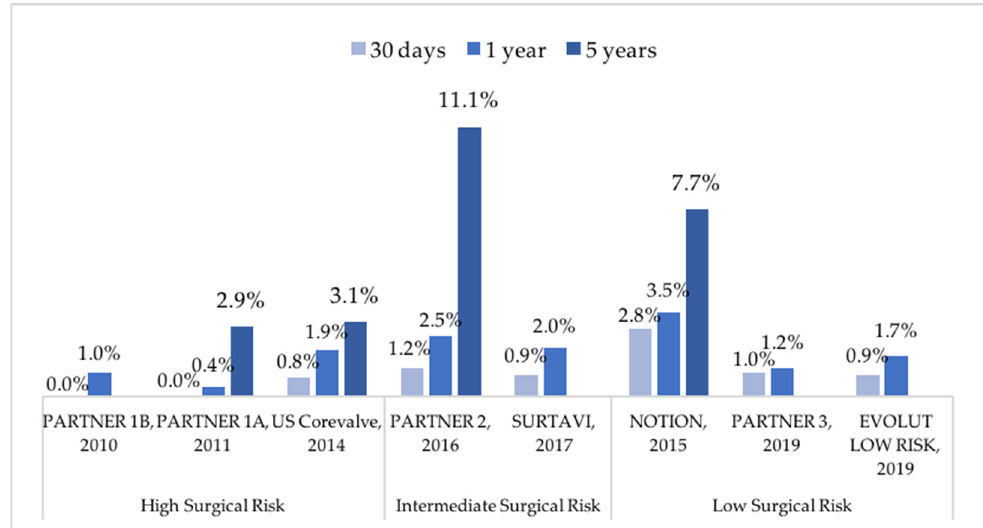
Figure 4. Reported incidences of myocardial infarction after transcatheter aortic valve replacement in pivot trials. NOTION: Nordic Aortic Valve Intervention Trial; PARTNER: Placement of Aortic Transcatheter Valve; SURTAVI: Safety and Efficacy Study of the Medtronic Corevalve© System in the Treatment of Severe, Symptomatic Aortic Stenosis in Intermediate Risk Subjects Who Need Aortic Valve Replacement. Table 1. Current Recommendations on Antithrombotic Therapy after TAVR .